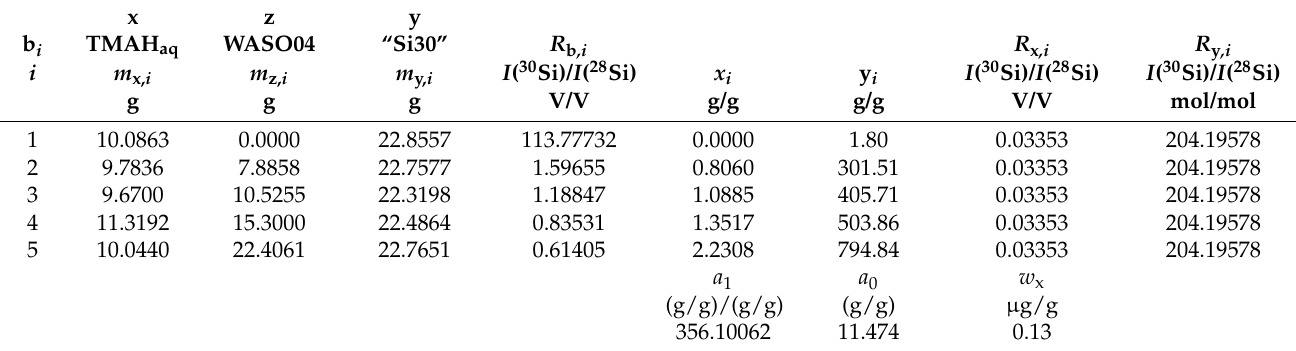
Table 2. Determination of w x (Si) in TMAH aq . The relevant input and output data of the linear regression analysis are given for a single representative dataset (Sequence 1), with w z = 4.0069 µ